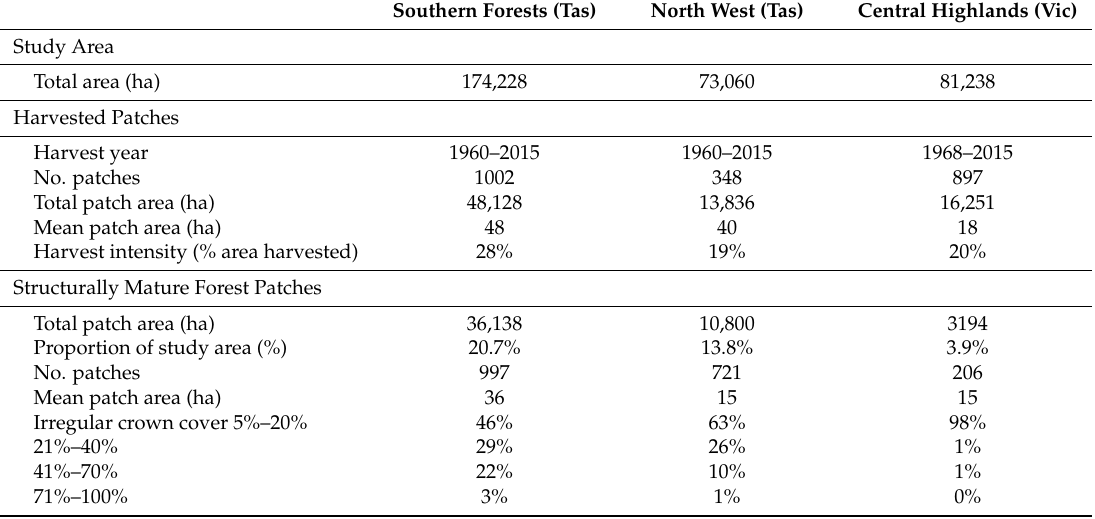
Table 1. Descriptive statistics for harvested patches and structurally mature forest patches (defined as having ≥ 5% irregular crown cover of eucalypts) in three study